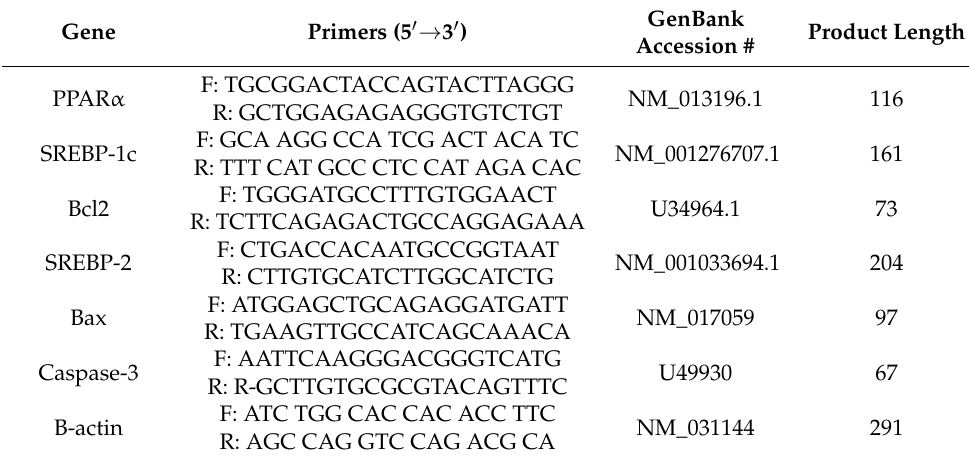
Table 1. Primer’s characteristics of the real-time